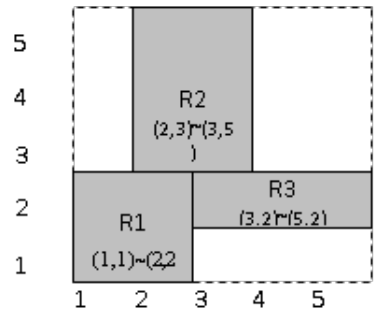
Fig. 10 An example of 2-d